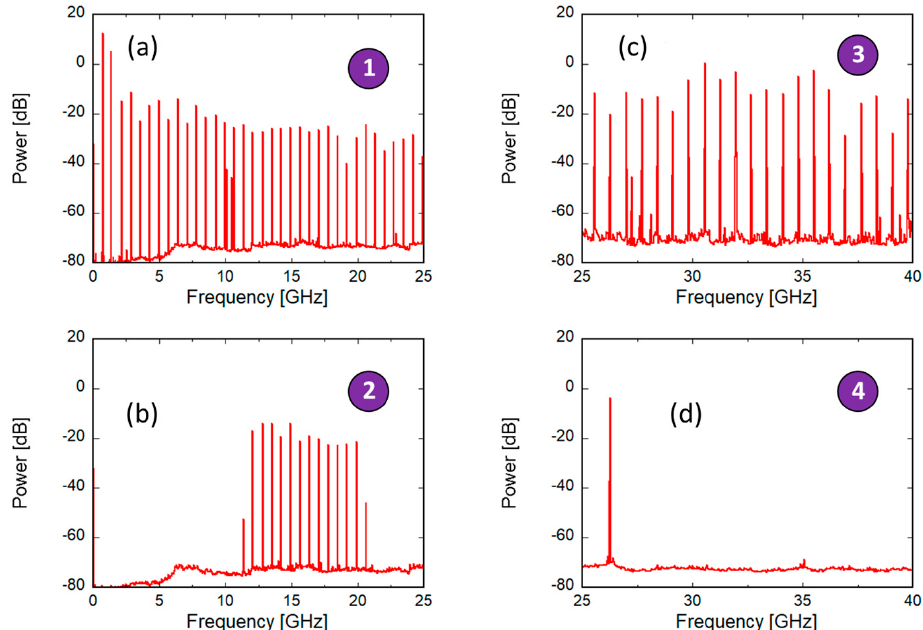
Figure 7. Frequency spectra of ( a ) output of comb generator (monitor point of 1), ( b ) output through bandpass filter (monitor point of 2), ( c ) output of multiplier which generates Ka-band frequency components (monitor point of 3), and ( d ) Local signal for Mixer 1 (monitor point of 4).